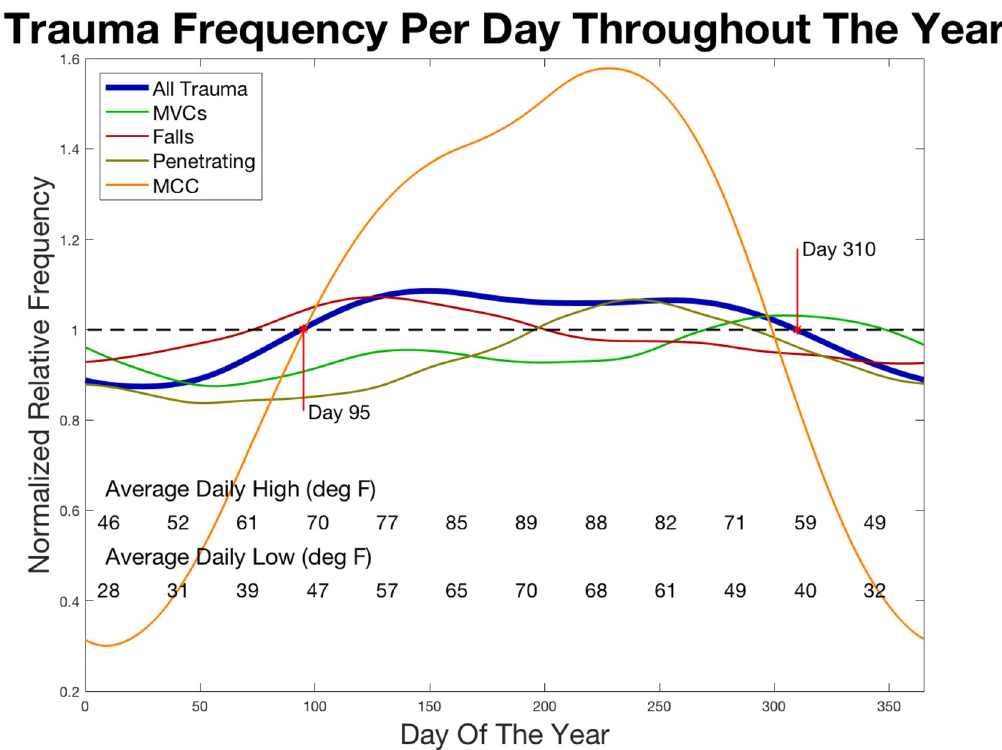
Fig 4. Smoothed, normalized relative trauma frequency per day throughout the year. All trauma (blue) shows above- median trauma during mid year. Several of mechanisms of injury (see legend) are considered additionally. The first point marks the date (day 95: April 5 th ) that this institution tends to see its median number of traumas. The second point (day 310: November 6 th ) denotes the end of the above-median yearly peak in trauma contacts per